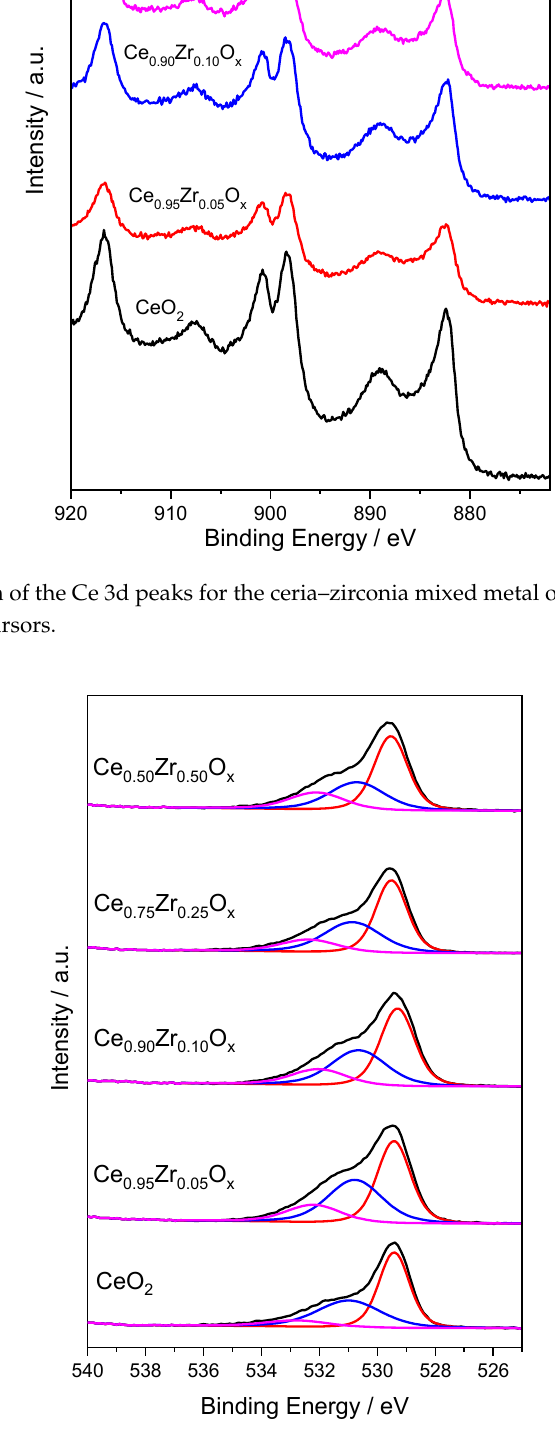
Figure 8. XPS spectra of the O 1s peaks of the ceria–zirconia mixed metal oxides prepared from carbonate precursors.